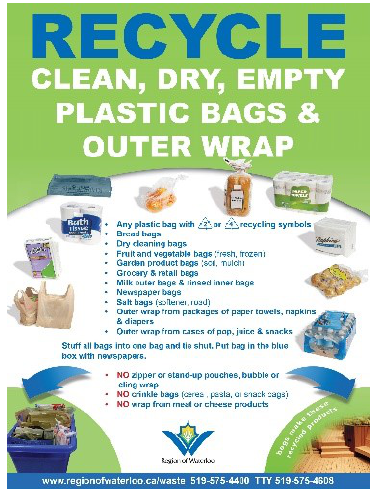
Figure 2. Sample Newspaper Advertisement # 1. Soc. Sci. 2016 , 5 , 23